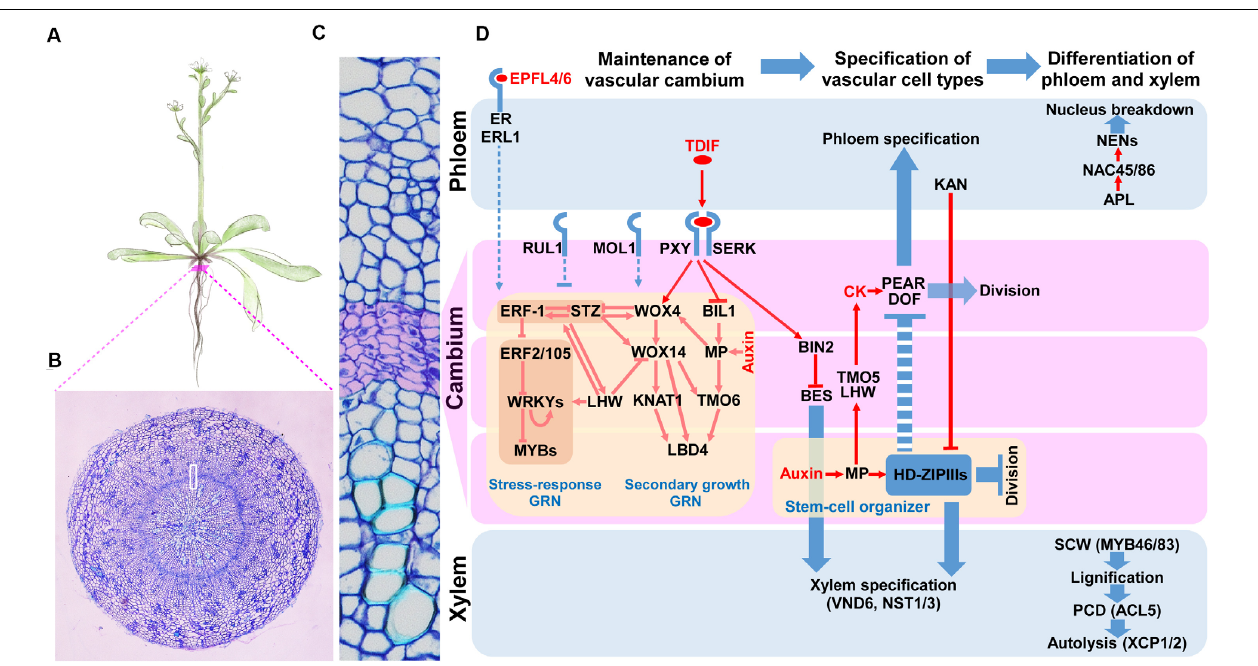
FIGURE 1 | Key signaling pathways and gene regulatory networks governing the vascular cambium in Arabidopsis. (A) A drawing depicting Arabidopsis plant. Red bar points to root cross-section shown in (B) . The white box in B indicates the enlarged root cross-section representing the vascular cambium and neighboring tissues shown in (C) . Cambium cell layer is highlighted in purple. (D) Key regulators functioning during the establishment and maintenance of vascular cambium, specification of vascular cell types and differentiation of vascular cells. Pointed arrows represent activation, while blunt arrows represent inhibition. Dashed lines denote indirect regulation. Red color represents regulation of gene or protein, while blue color denotes regulation of process. Purple boxes represent cambium, while upper and lower blue boxes represent phloem and xylem precursors, respectively, as well as their derivatives. Shaded rectangles indicate